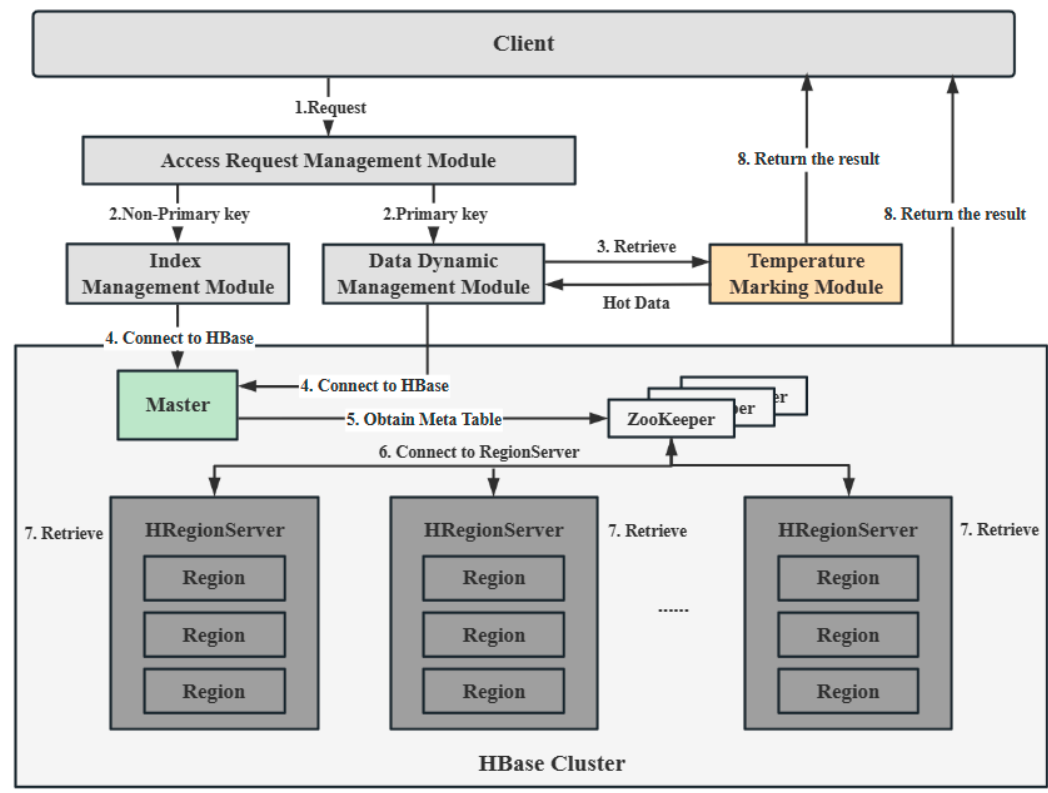
Figure 6. Overview of the model designed.